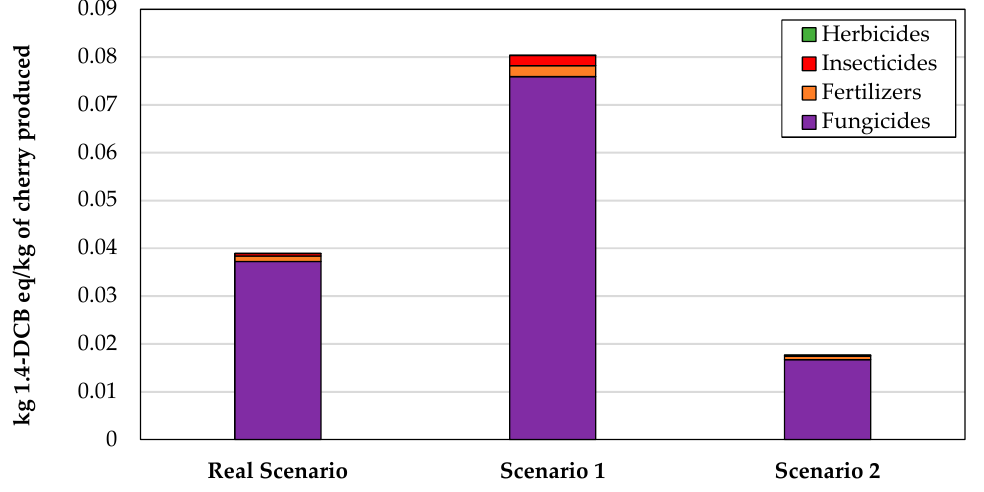
Figure 7. Terrestrial ecotoxicity for the FU of 1 kg of produced cherry for the real and test scenarios, considering the herbicides, insecticides, fertilizers and fungicides environmental impacts. Table 6. Terrestrial ecotoxicity indicator for an FU of 1 kg of produced cherry for scenarios 1 and 2. Environmental Aspects with